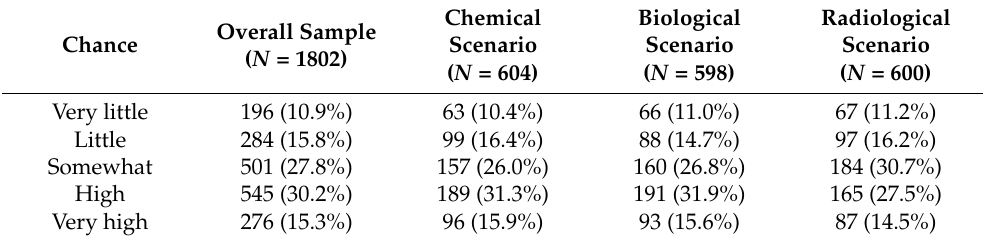
Table 3. Distribution of responses ( n , %) to the question “if the news report you read took place in reality, what do you think were the chances that you would seek medical attention at the hospital?”. Chemical Biological Radiological Overall Sample Chance Scenario Scenario Scenario ( N = 1802) ( N = 604) ( N = 598) ( N = 600) Very little 196 (10.9%) 63 (10.4%) 66 (11.0%) 67 (11.2%) Little 284 (15.8%) 99 (16.4%) 88 (14.7%) 97 (16.2%) Somewhat 501 (27.8%) 157 (26.0%) 160 (26.8%) 184 (30.7%) High 545 (30.2%) 189 (31.3%) 191 (31.9%) 165 (27.5%) Very high 276 (15.3%) 96 (15.9%) 93 (15.6%) 87